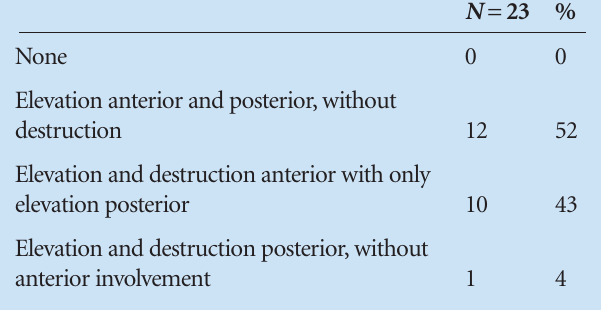
Table VII. Longitudinal ligament involvement